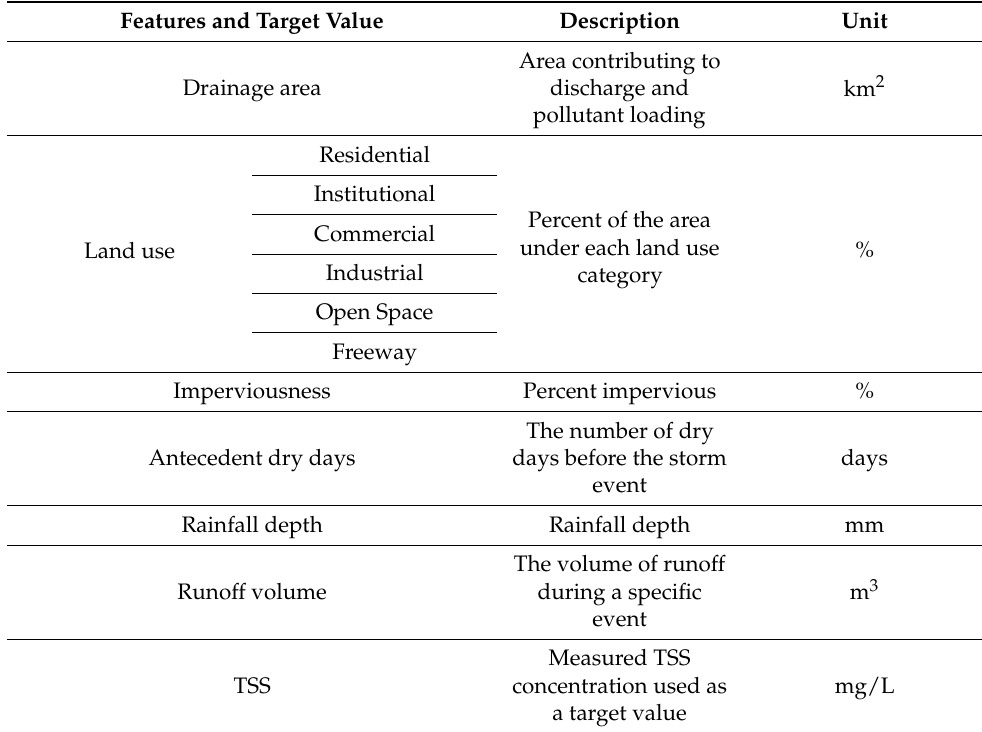
Table 1. Summary of features and target values.